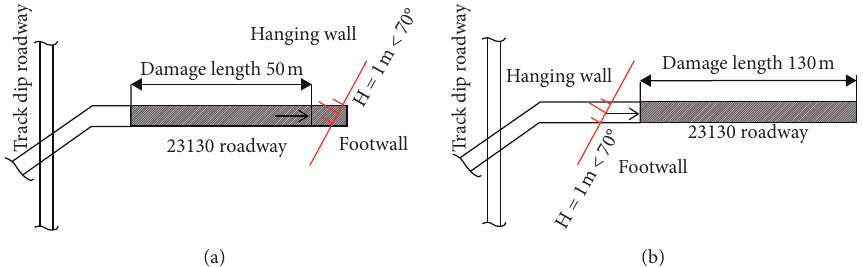
Figure 9: Blasting vibration induce fault rock burst. (a) The rock burst occurred in the hanging wall of the fault. (b) The rock burst occurred in the footwall of the